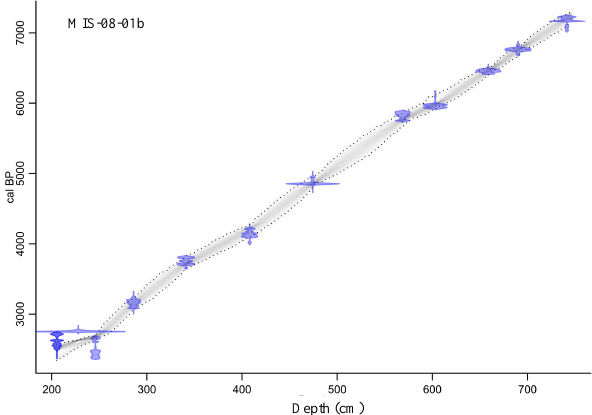
Fig. 2. Bacon age–depth model for the MIS-08-01b core. Grey scales indicate all likely age–depth models, and dotted lines indi- cate the 95% confidence